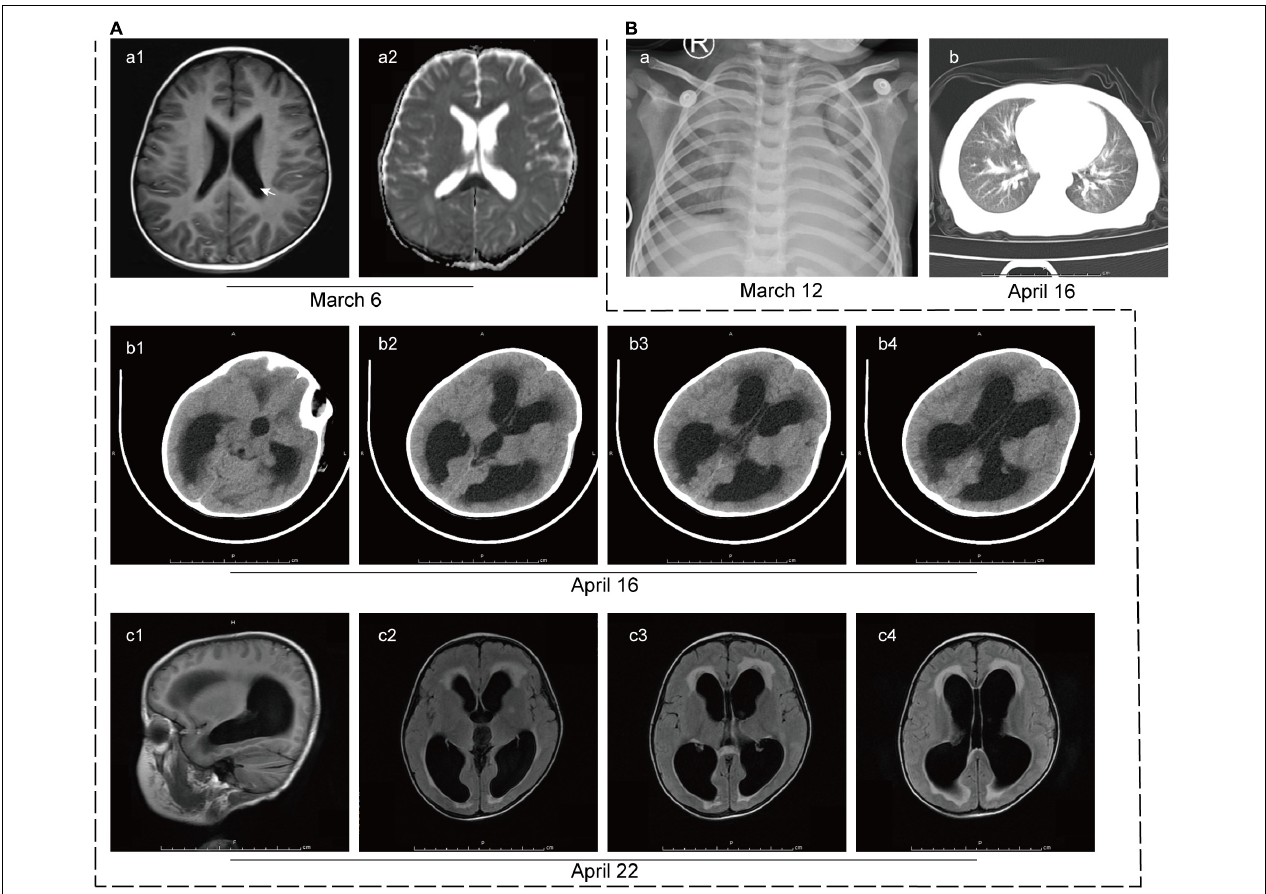
FIGURE 2 | Imaging tests of the patient. (A) Imaging tests of the brain. (a) Brain diffusion-weighted MRI on 6 March 2020 revealed multiple intracranial abnormal signals with the slightly enlarged posterior horn of the lateral ventricle (white arrow). (b) CT scan of the brain on 16 April 2020 showed hydrocephalus and interstitial edema of white matter. (c) T2-Flair MRI images of the brain on 22 April 2020 showed multiple patchy shadows in the splenium of the corpus callosum, frontal lobe, and left basal ganglia, suggesting infectious changes. Hydrocephalus and interstitial edema were also observed. (B) Imaging tests of the lung. (a) The initial lung X-ray image of the patient on 12 March 2020 showed infection in the bilateral lungs. (b) CT scan of the lung on 16 April 2020 revealed patchy shadows on bilateral lungs, suggesting